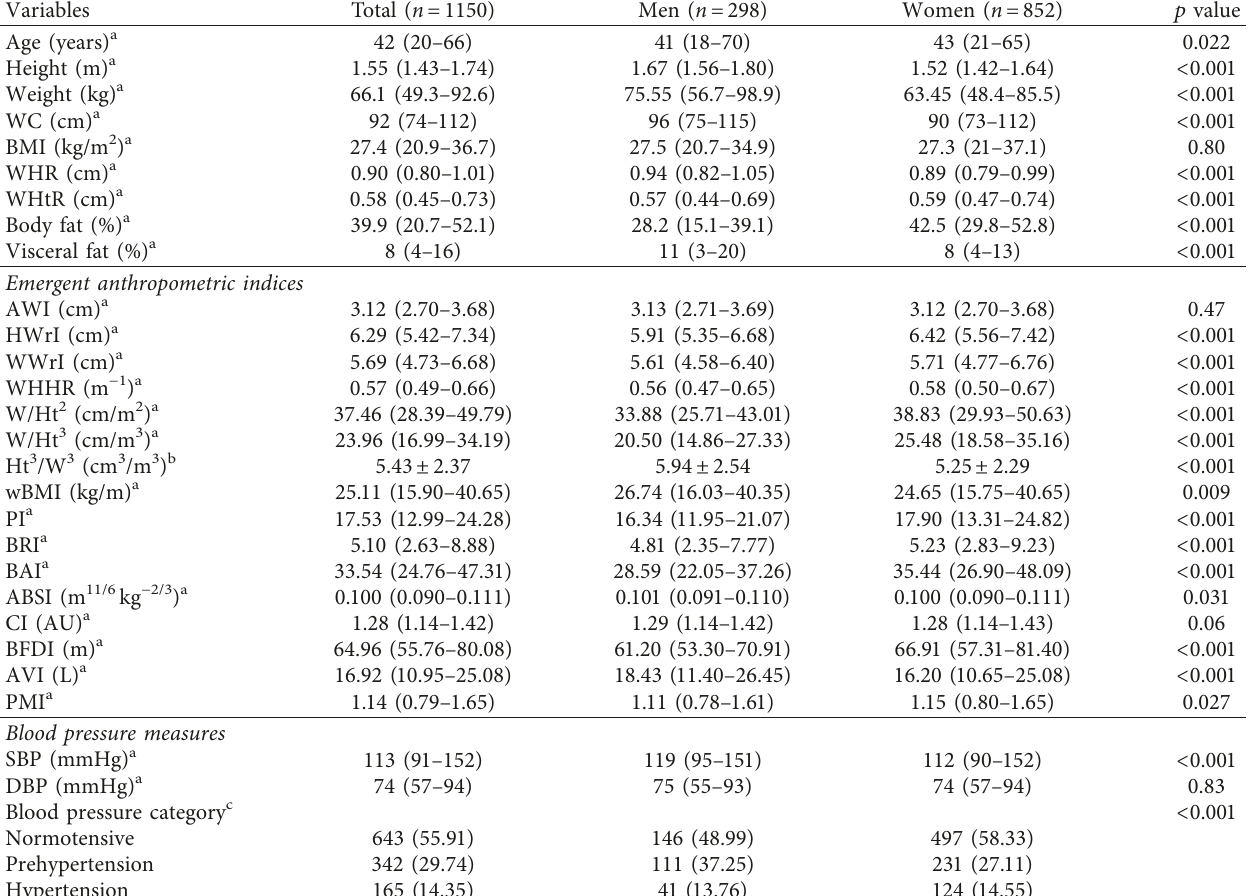
Table 1: Anthropometrics and clinical characteristics of the study population according to